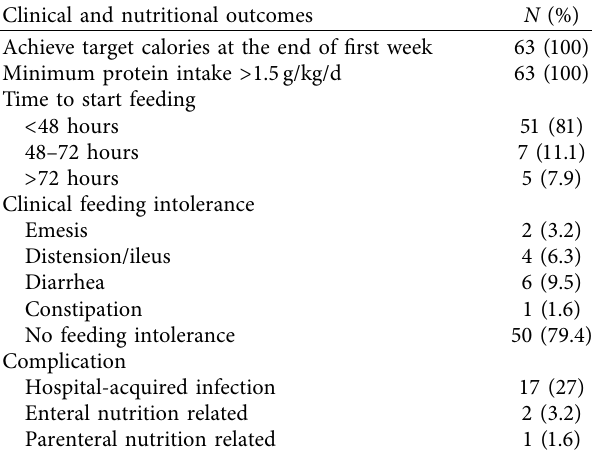
Table 2: Clinical and nutritional outcomes. Clinical and nutritional outcomes